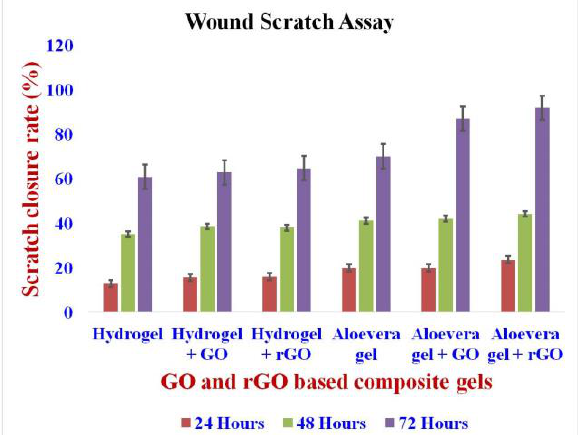
Figure 13. Wound scratch assay of GO and rGO-based composite gels. The study revealed a high level of cell migration, thus revealing significant wound scratch closure.